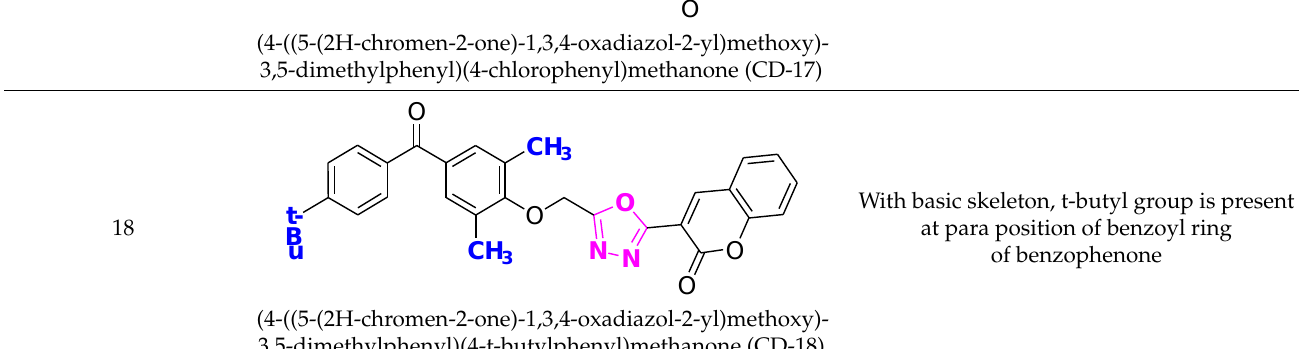
With basic skeleton, chloro group is present at para position of benzoyl ring of